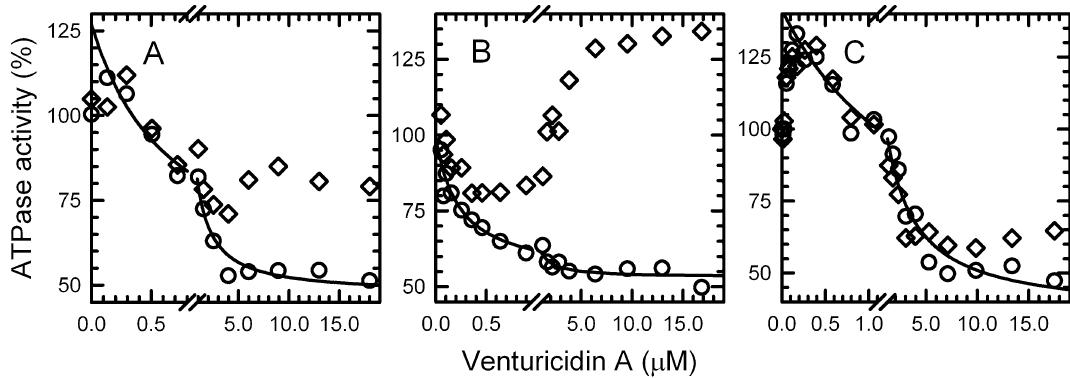
Figure 2. Concentration-dependence of venturicidin A’s immediate and time-dependent effects on the ATPase rate of WT E. coli membranes. WT membranes were assayed as in Fig. 1 and ATPase rates were measured ‘early’ (within 1 min after adding ventA, ○ ) and ‘late’ (during last 5 min of 30-min assay, ◊) in the absence ( A ) or presence of 38.5 mM selenite ( B ) or 6 μM azide ( C ). In each panel, the line shows the best fit of a hyperbolic equation, y = y 0 + y 1 /(1 + x/K i ), to the range of early rates ( ○ , y ) that decrease with increasing ventA concentration (x); this includes all points with [ventA] > 0 for panel ( A ), all points for panel ( B ), and points with > 0.15 μM ventA for panel ( C ). The activity (U/mg) corresponding to 100% for each condition and the best fit parameters for each curve are in Table